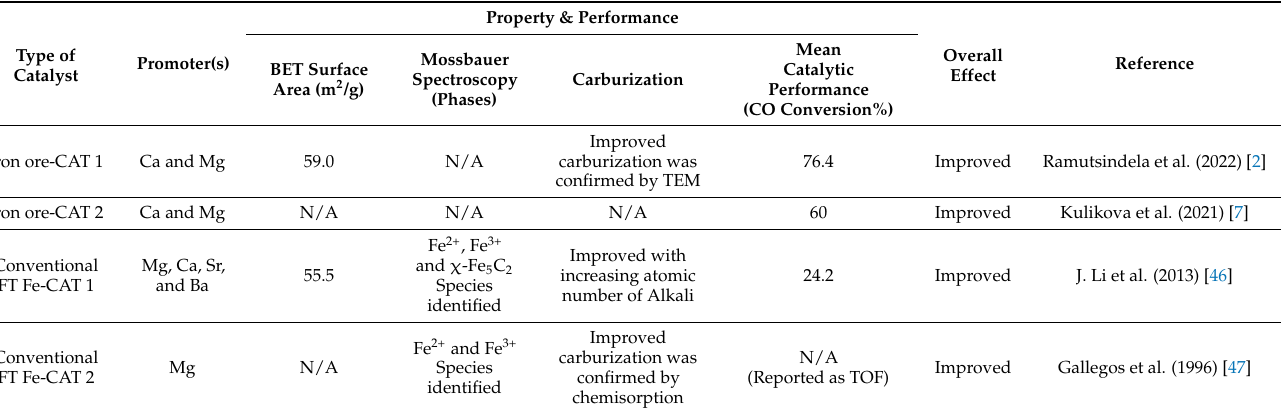
Table 2. The effect of alkaline earth metals on the properties of iron ore and conventional Fe-FT catalysts and their overall